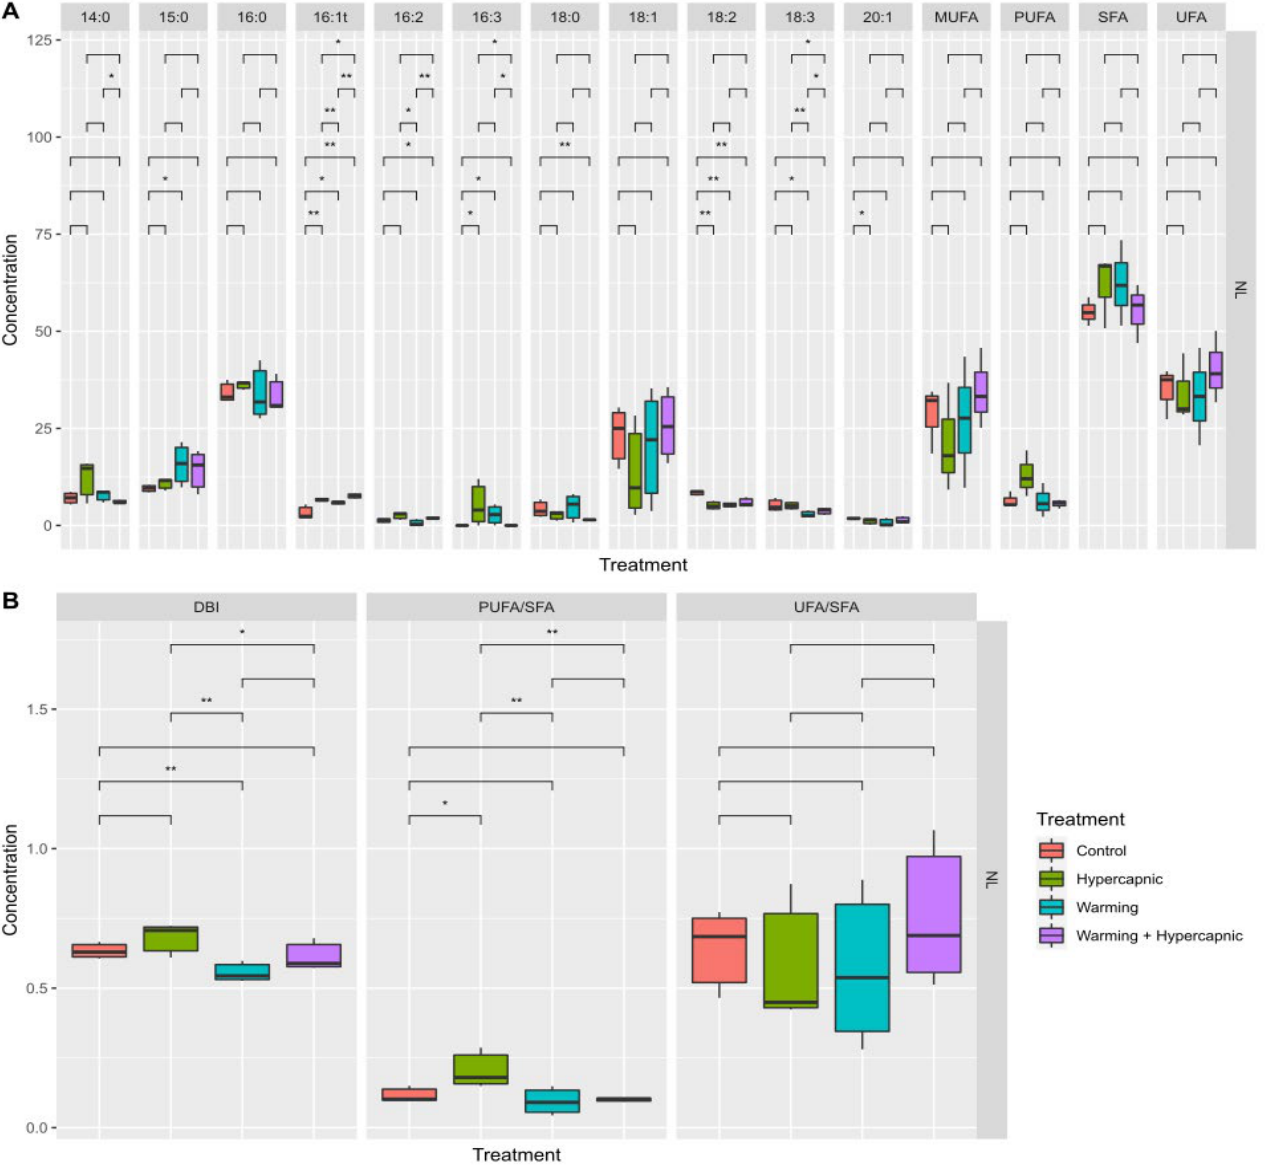
Figure 9. Zostera noltii neutral lipid (NL) fatty acid composition and saturation and classes (monounsaturated fatty acids (MUFAs), polyunsaturated fatty acids (PUFAs), saturated fatty acids (SFAs), and unsaturated fatty acids (UFAs)) ( A ) and fatty acid indexes and ratios (double-bond index, DBI; polyunsaturated to saturated fatty acid ratio, PUFA/SFA; unsaturated to saturated fatty acid ratio, UFA/SFA) ( B ) ( n = 3 per treatment; asterisks denote statistical differences among treatments at p < 0.05 (*) and p < 0.01 (**)) of the samples exposed to control, hypercapnic, warming and combined stress conditions